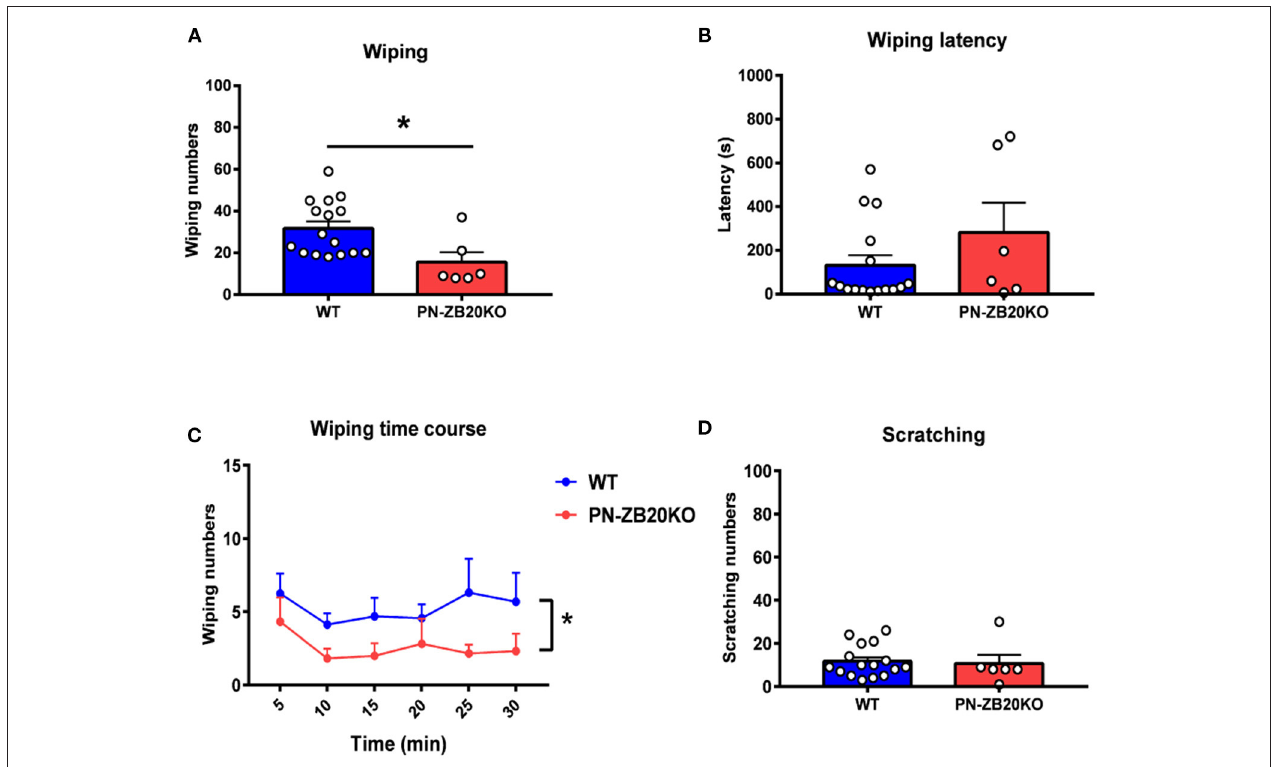
FIGURE 3 | Capsaicin-induced wiping was dramatically attenuated in PN-ZB20KO mice. (A) The wiping behavior induced by injection of capsaicin (10 µ g in 10 µ L of solution) into the mouse cheek was decreased dramatically in PN-ZB20KO mice compared to control mice ( t -test, * p < 0.05). (B) The latency to wiping following capsaicin injection did not change in PN-ZB20KO mice compared to control mice ( t -test, p > 0.05). (C) The time course of wiping induced by capsaicin administration. Two-way ANOVA [ F (1, 20) = 6.958; p = 0.0158, * p < 0.05]. (D) The scratching induced by capsaicin was maintained at a low level and did not change after capsaicin administration. N = 6–16 for each